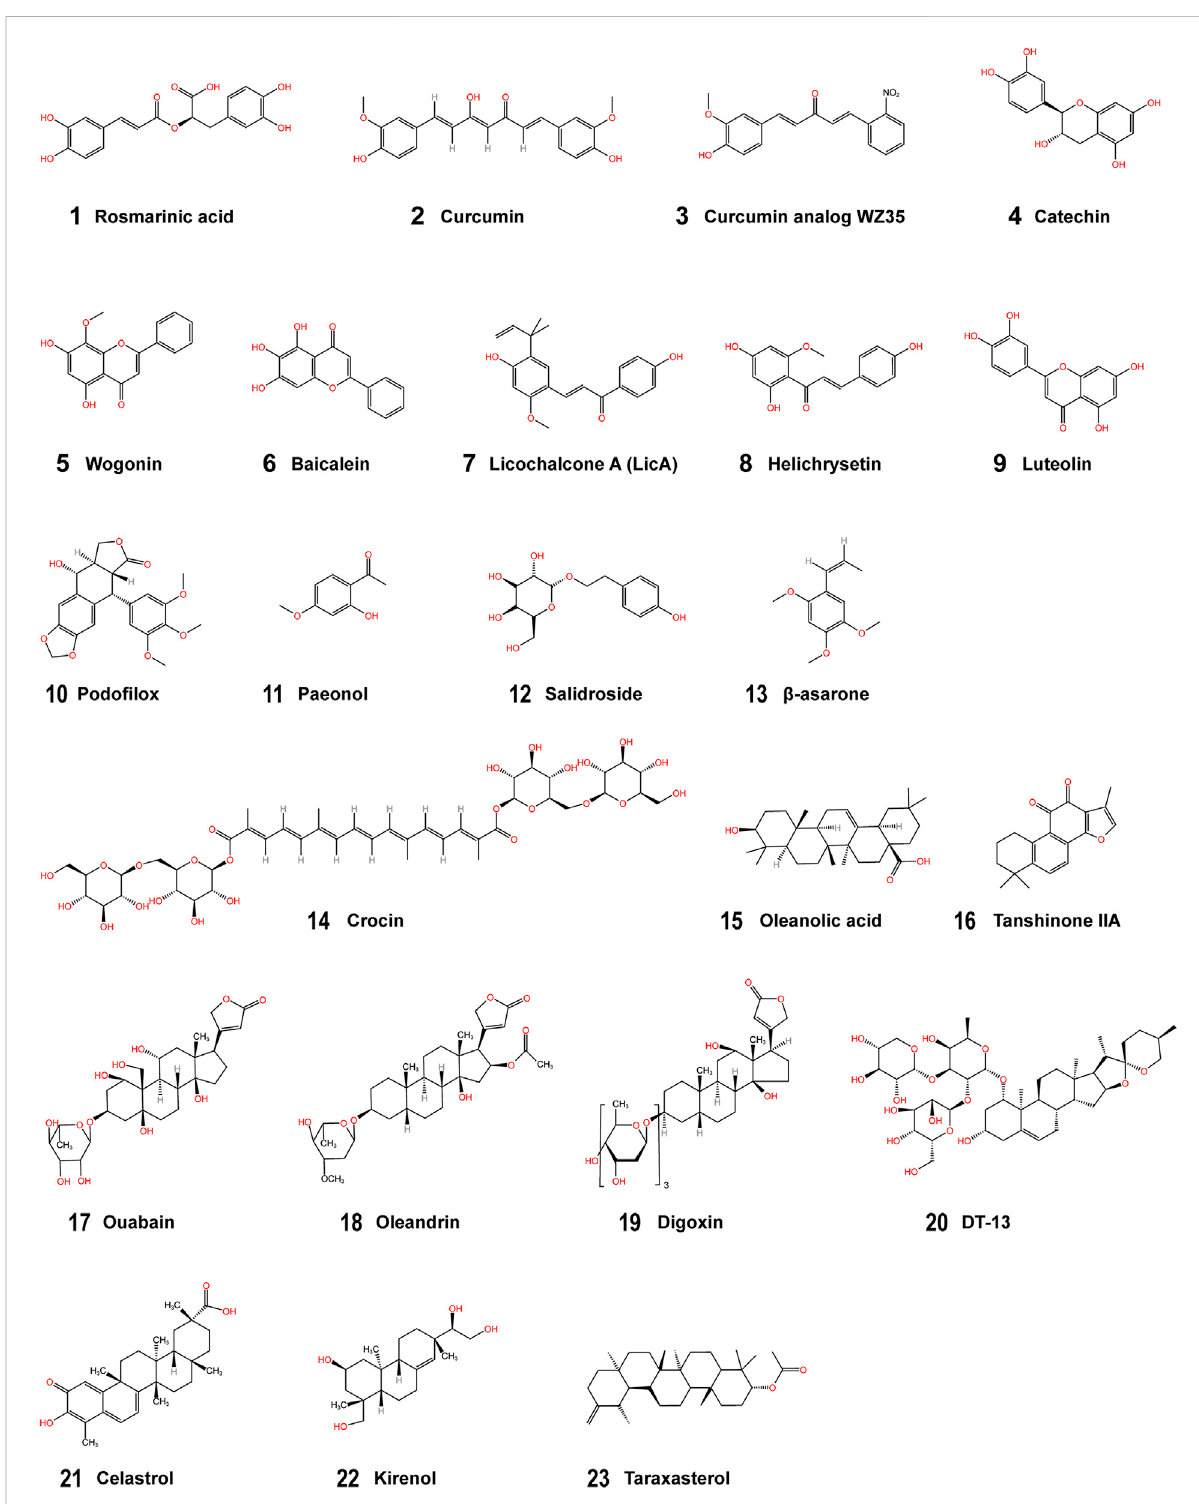
FIGURE 2 Structuralformulaeofthephytochemicals. (1 – 4) Phenoliccompounds; (5 – 9) Flavonoids; (10 – 13) Phenylpropanoids; (14 – 22) Terpenoids; (23) Other